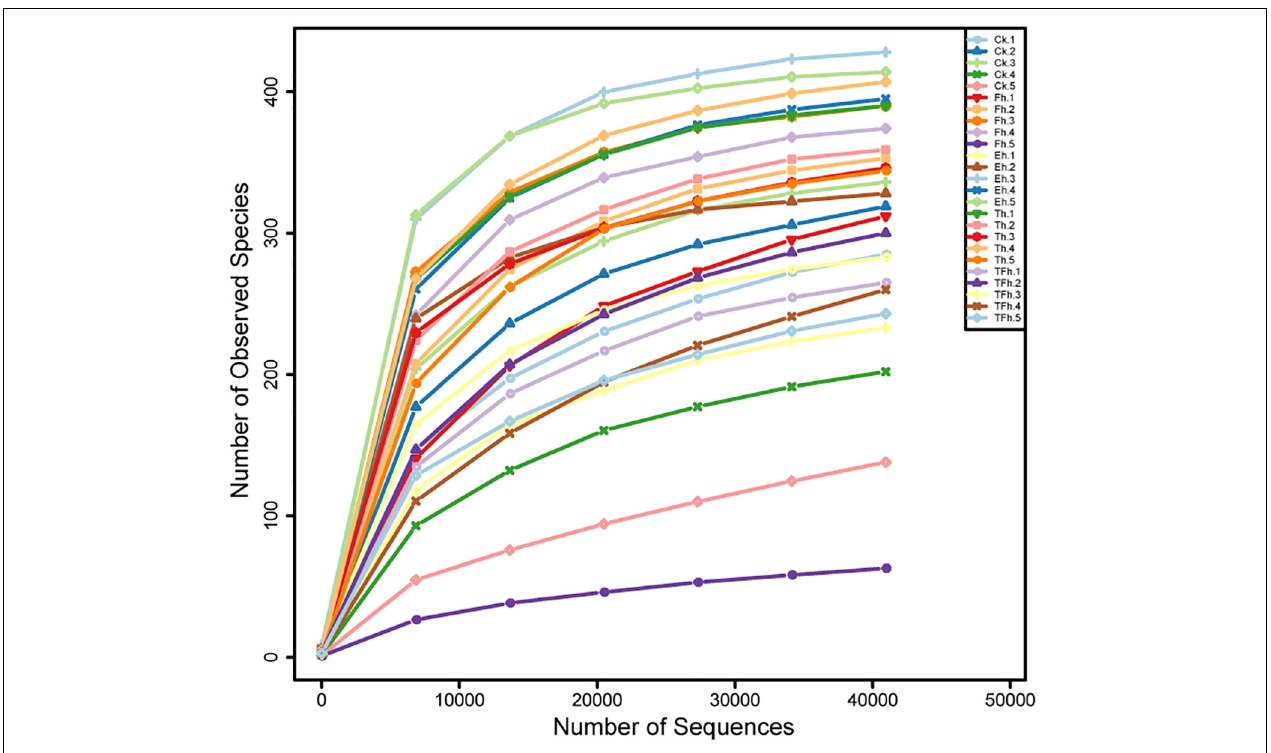
FIGURE 1 | Rarefaction curves based on the numbers of operational taxonomic units (OTUs) observed in the gut microbial communities of E. grisescens larvae after 0 h (CK), 4 h (Fh), 8 h (Eh), 12 h (Th), and 24 h (TFh) starvation